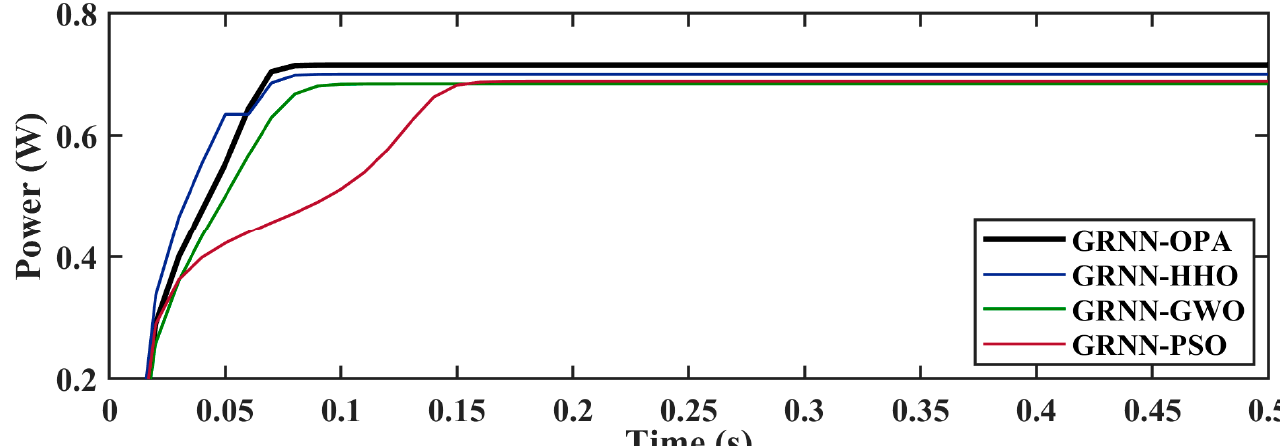
Figure 7. Comparison of power tracked in case 1.